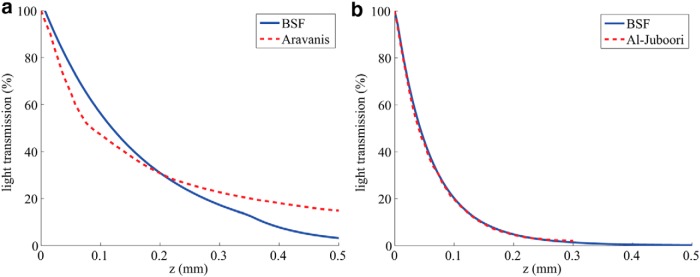
Transmission of light along the z-axis, comparing published experimental results (red dotted curves) with BSF method (blue curves). a, Best-fit curves to measured data from Aravanis et al. (2007). b, Experimental data from Al-Juboori et al. (2013) measured from the peduncopontine tegmental nucleus; the optical parameters used for the BSF curve are explained in the text.